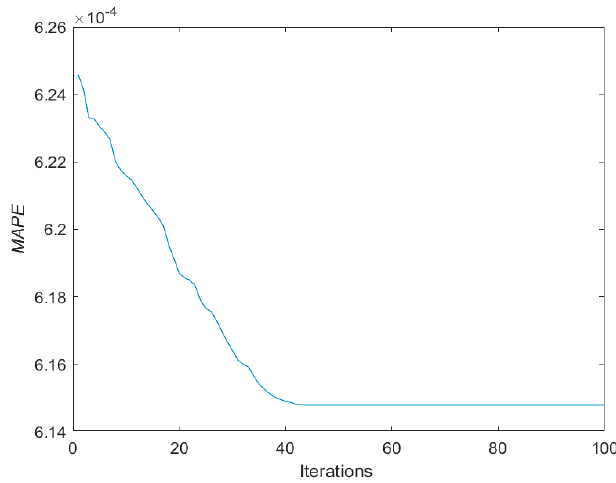
Figure 3. The convergence process of MAPE. By calculation, the fractional order r is 0.5539, and then it is substituted into the FGM (1,1) model for calculation.